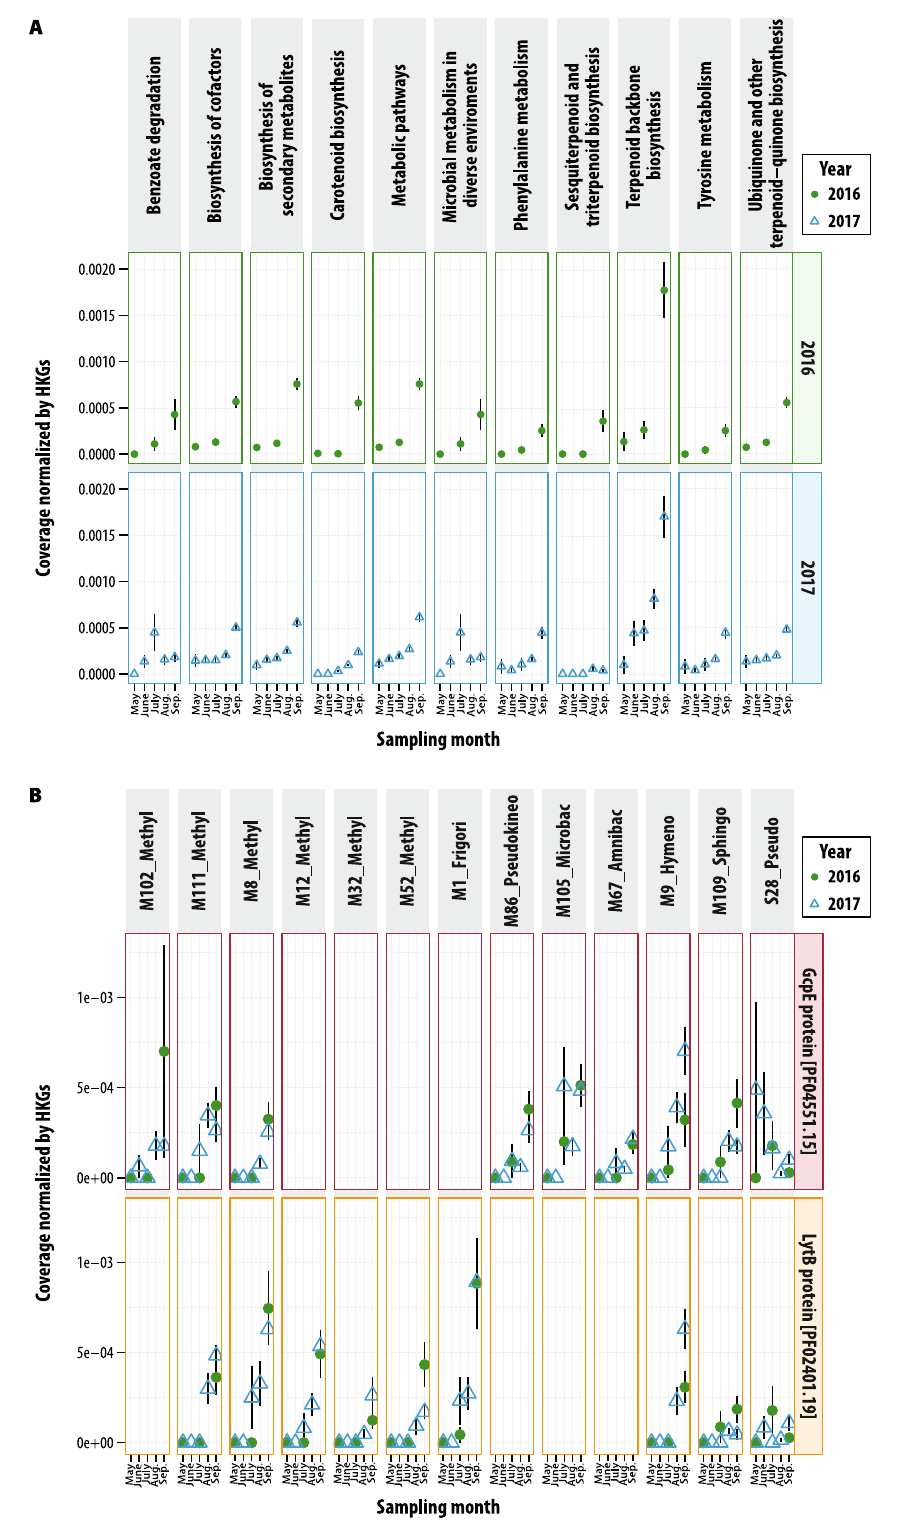
Fig. 7 | Switchgrass microbiome transcripts detected over two growing sea- sons. A 2016 (green, circle) and 2017 (blue, triangle) switchgrass leaf transcript dynamicsofKEGGmetabolismclassi fi cationsassociatedwithterpenemetabolism. B Transcripts in MAGs associated with terminal enzymes in the non-mevalonate isoprene biosynthesis, gcpE and lytB . MAG IDs include predicted taxonomy at the genus level: Methyl= Methylobacterium , Frigor= Frigoribacterium , Pseudokineo=